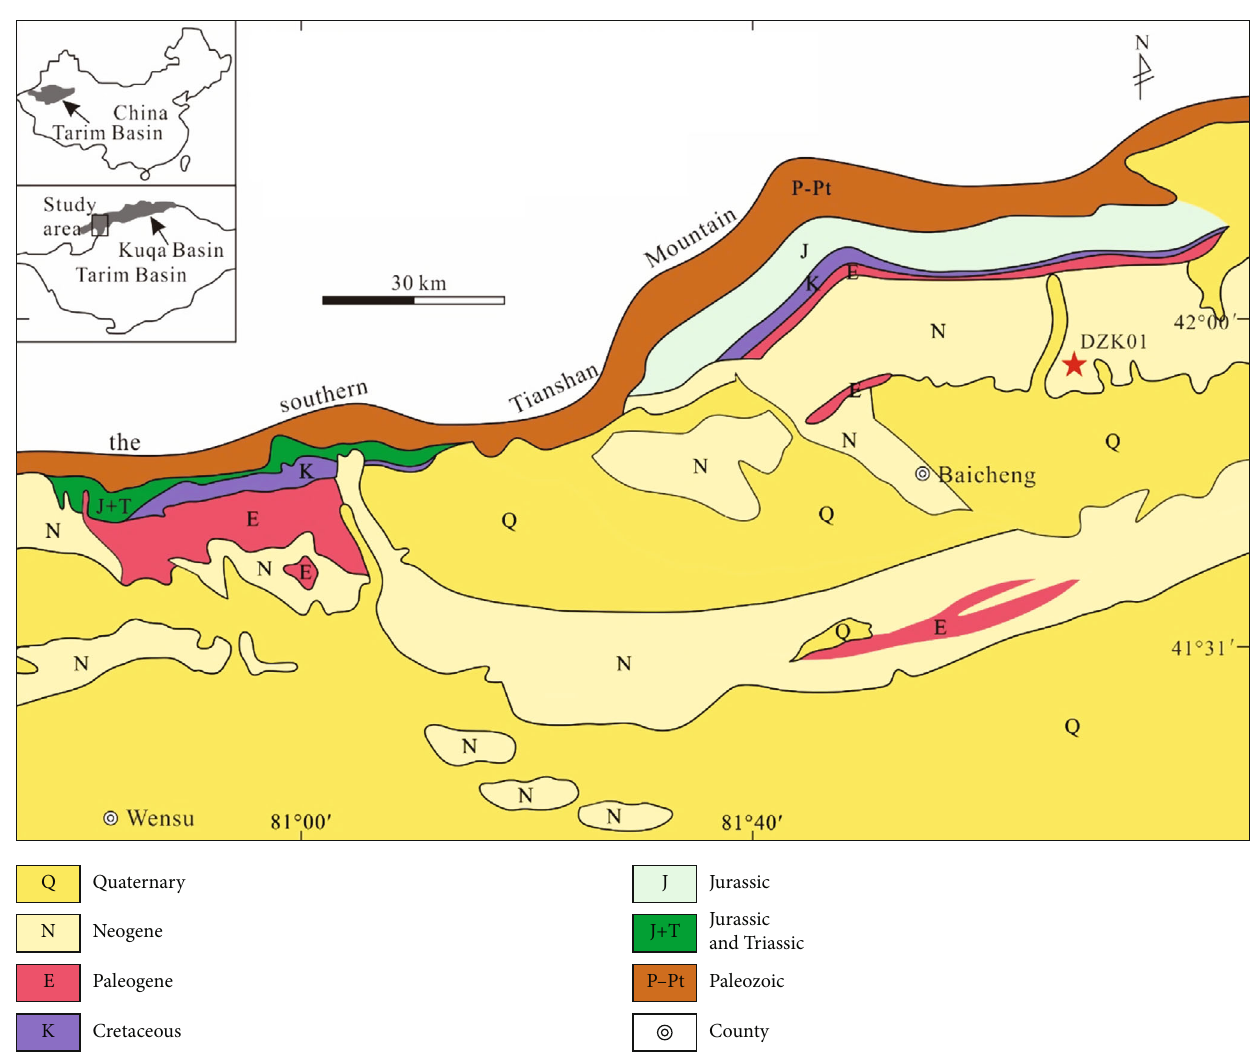
Figure 2: Simpli fi ed geological map of the Kuqa Basin